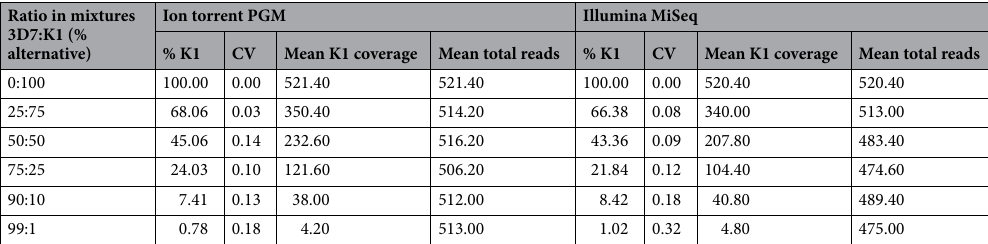
Table 1. Detection of mixed alleles in different artificial mixture ratios of P. falciparum 3D7 and K1. The percentage of K1 allele was calculated from five SNP positions (the coverage reads more than 500X in two TADs protocols) with triplicate sets of random subreads. The two NGS protocols can detect down to 1.00% of K1 strain. The coefficient of variant (CV) was calculated. The CV of 1.00% K1 strain mixture in the Ion Torrent PGM protocol was 0.18 and 0.32 in the Illumina MiSeq.